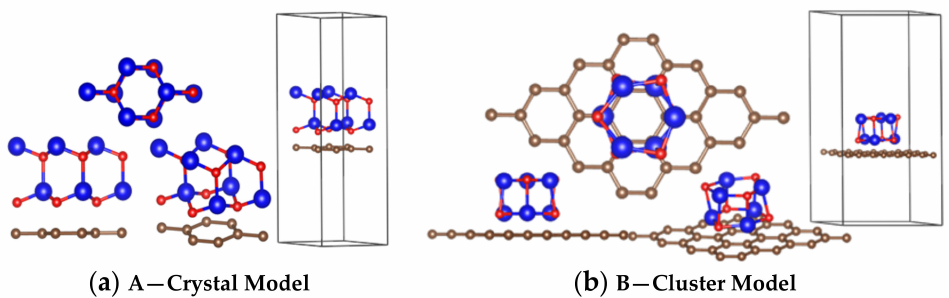
Figure 2. Calculation models: ( a ) crystal ZnO/graphene interface model; ( b ) cluster (amorphous) ZnO/graphene interface model. Color code: Carbon, brown; Zinc, blue; Oxygen,